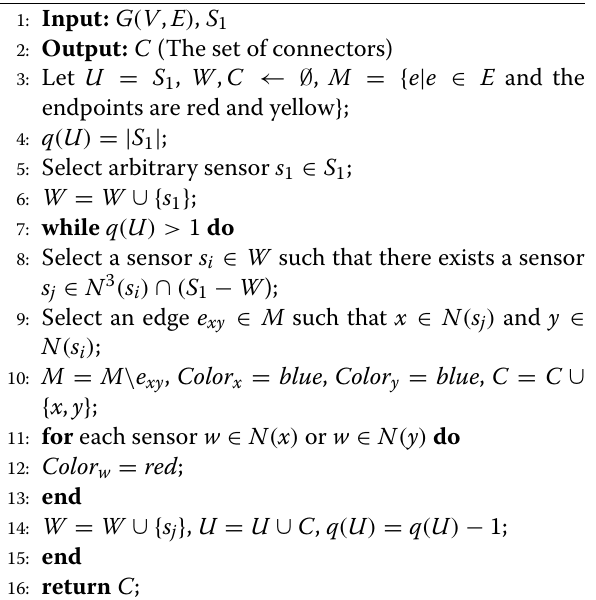
Algorithm 2 Connecting S 1